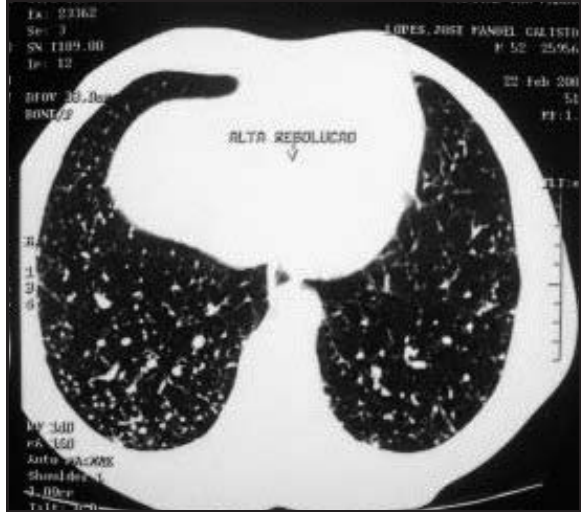
Figura 2 – Tomografia de tórax mostrando infiltrado micronodular difuso